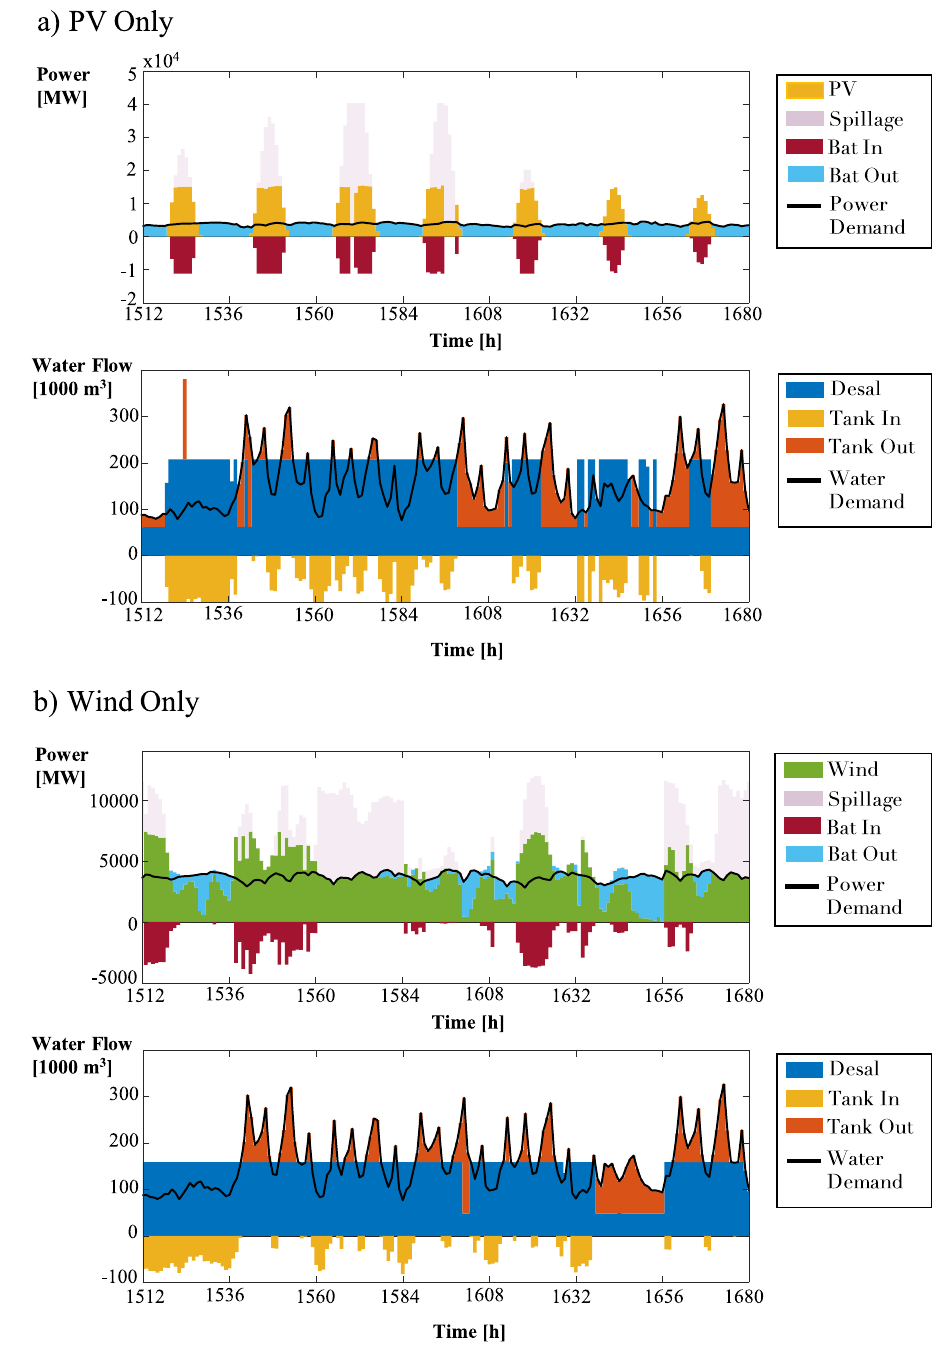
Fig. 4 Power and water system operations in year 10 for the a) Photovoltaics (PV) Only and b) Wind Only cases. Co-optimization allows water production to decrease during hours when batteries are discharging to meet the majority of or all power